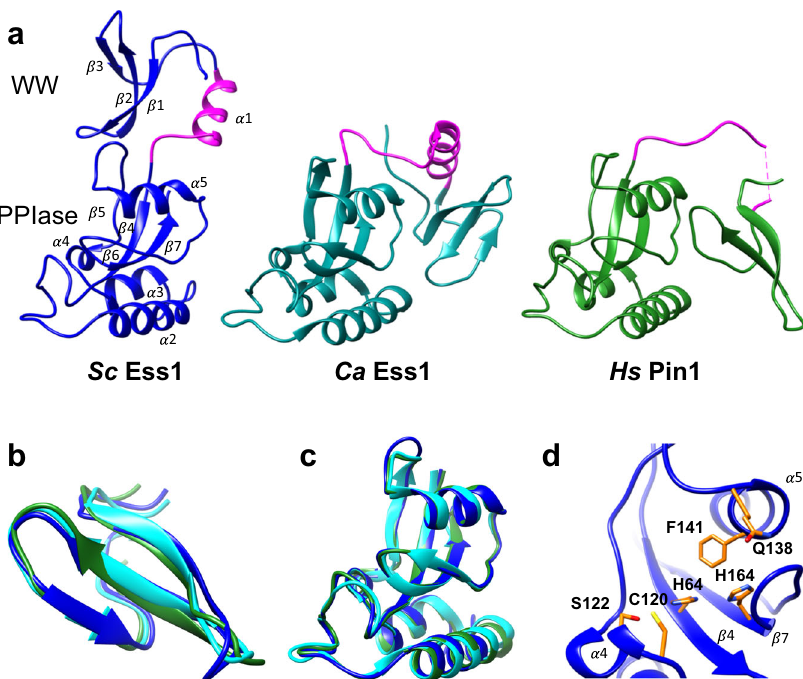
Fig. 1 The crystal structure of the S. cerevisiae Ess1 protein reveals an elongated protein with a well-ordered linker joining the WW and catalytic domains. a Comparison of S. cerevisiae Ess1, residues 9 – 170, (blue), C. albicans Ess1 (PDB ID: 1YW5) (cyan) and human Pin1 (PDB ID: 1PIN) (green) highlighting the different relative positions of the two functional domains. Linker regions are highlighted (pink). b Superposition of the WW domains (C α ) of each protein shown in ( a ). The overall degree of similarity is very high (RMSD < 0.7 Å). c Superposition of the PPIase (catalytic) domains (C α ) of each protein in ( a ) shows a high degree of similarity (RMSD < 0.7 Å). d Close-up of the catalytic site within the Sc Ess1 PPIase domain, with critical residues highlighted. Each of these residues in Sc Ess1 (H64, C120, H164, S122 Q138, F141) is conserved in Hs Pin1 (see text).